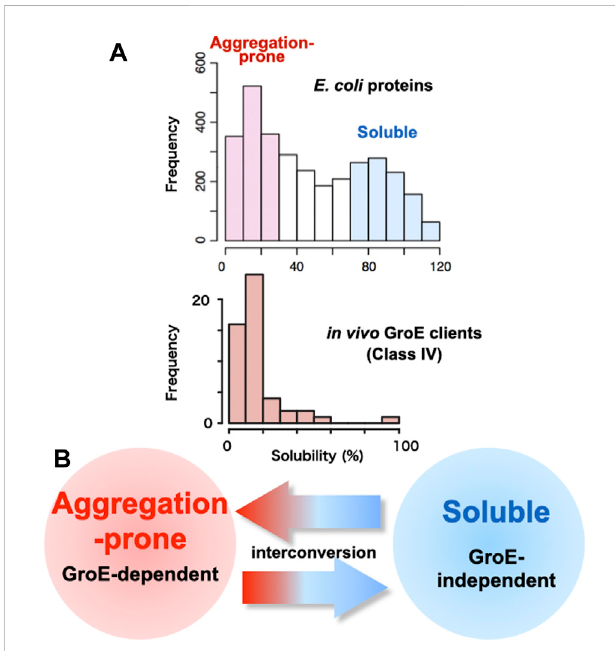
FIGURE 1 Relationship between GroE-dependency and protein solubility (A) Histogramsofsolubilitydistributionsfor3,173 E.coli proteins(Niwaetal., 2009) and obligate GroE-dependent clients (Class IV clients) (Fujiwara et al., 2010). Inherent protein solubilities under chaperone-free conditions were determined by a global aggregation analysis, using a reconstituted cell-free translation system (PURE system). Solubility scores,representingtheindexoftheaggregationpropensity,arede fi ned as the proportion of the supernatant fraction, obtained after the centrifugation of the translation mixture, to the uncentrifuged total protein (Niwaetal., 2009). (B) Interconversion ofthe aggregation-prone propensity and the